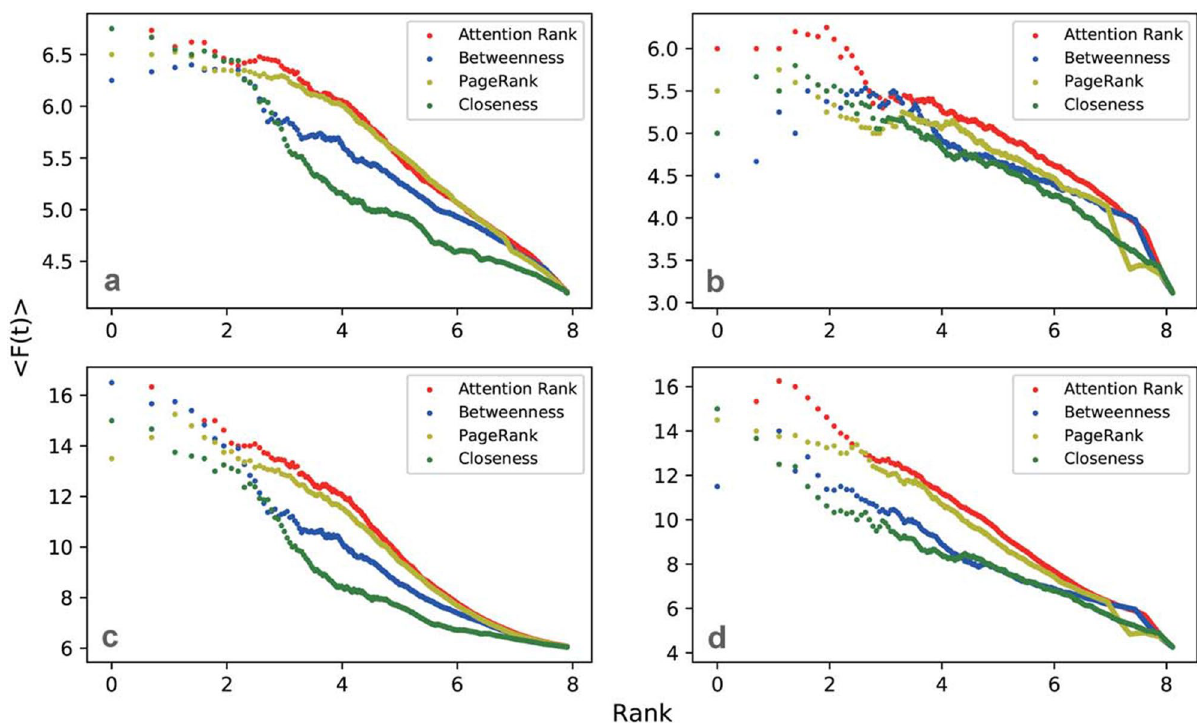
Figure 1. The comparison between the spreading power of different ranking algorithms over (cid:31) F ( t ) (cid:30) . In panels ( a ) and ( b ), we plot the average number of (cid:31) F ( t ) (cid:30) for t = 3 of the top-L users as ranked by the five centrality measures of Cora ( a ) and Citeseer ( b ) graphs, while in panels ( b ) and ( d ), we plot the average number of (cid:31) F ( t ) (cid:30) for t = 9 of Cora ( c ) and Citeseer ( d ) graphs.